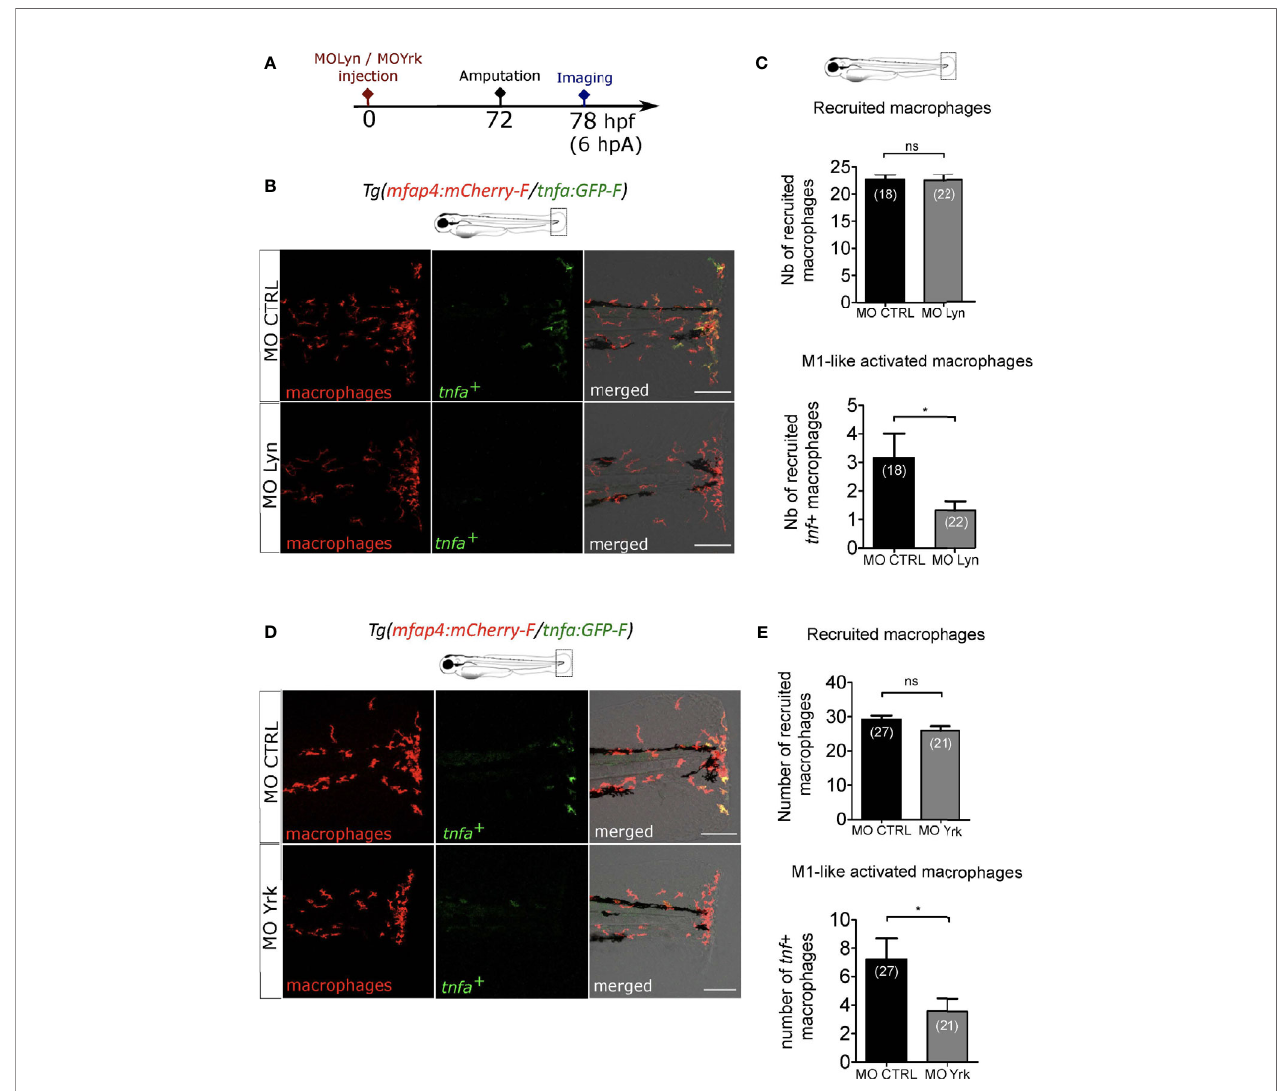
FIGURE 7 | Macrophage-expressed SFKs Lyn and Yrk are enrolled in macrophage activation. (A) Schedule of the experiment. Morpholinos targeting speci fi cally lyn (MO Lyn) or yrk (MO Yrk) or morpholino control (MO CTRL) were injected in Tg(mfap4:mCherry/tnfa:GFP-F) at one-cell stage. At 3 dpf, fi n folds were amputated and larvae were imaged at 6 hpA using confocal microscopy. (B) Tail images are representative maximum projections of the fl uorescence of mCherry-F (macrophages), GFP-F ( tnfa + cells) and merged channel images with bright fi eld at 6 hpA, after the injection of MO CTRL (up) or MO Lyn (down). Scale bar: 100 m m. (C) Quanti fi cation of recruited macrophages (up) and tnfa + recruited macrophages (down) in controls and in Lyn morphants at 6 hpA. Two independent experiments merged, mean ± SEM, n larvae is indicated in brackets, upper graph: two-tailed t-test, ns – not signi fi cant, bottom graph: Mann Whitney test, two-tailed, *p<0.05. (D) Tail images are representative maximum projections of the fl uorescence of mCherry-F (macrophages), GFP-F ( tnfa + cells) and merged channel images with bright fi eld at 6 hpA, after the injection of MO CTRL (up) or MO Yrk (down). Scale bar: 100 m m. (E) Quanti fi cation of recruited macrophages (up) and tnfa + recruited macrophages (down) in controls and in yrk morphants at 6 hpA. Two independent experiments merged, mean ± SEM, n larvae is indicated in brackets, two-tailed t-test, ns – not signi fi cant,